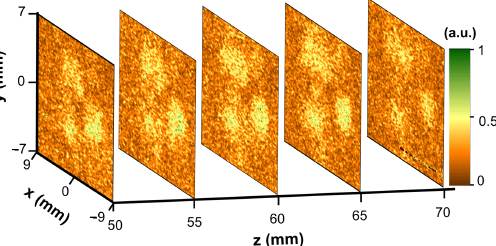
Figure 6. Spatial beam profiles of System 1 recorded by 0.7 THz Ti- µ bolometer without collimating lens at different distances along the beam propagation direction. Note different spatial antenna modes visible along the propagation